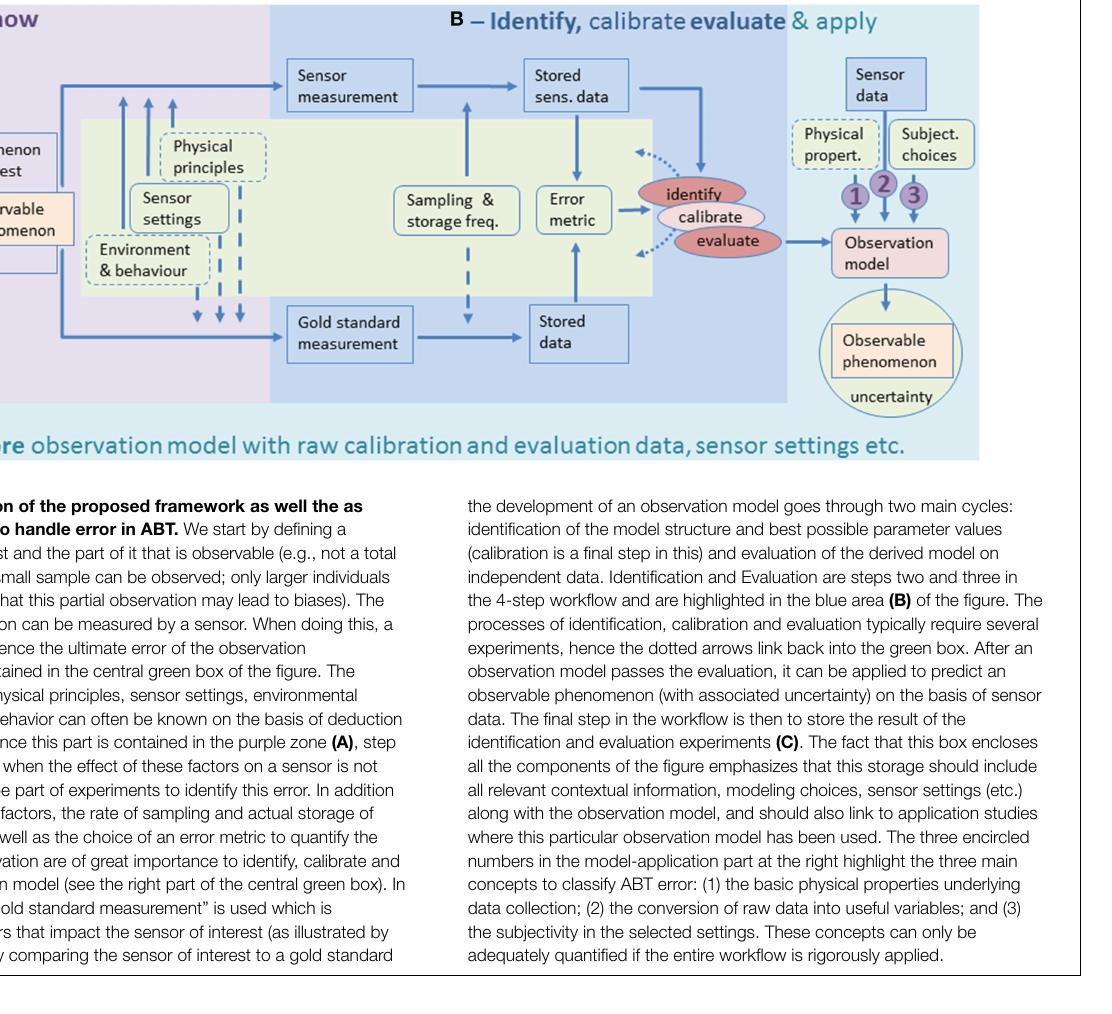
Frontiers in Ecology and Evolution |